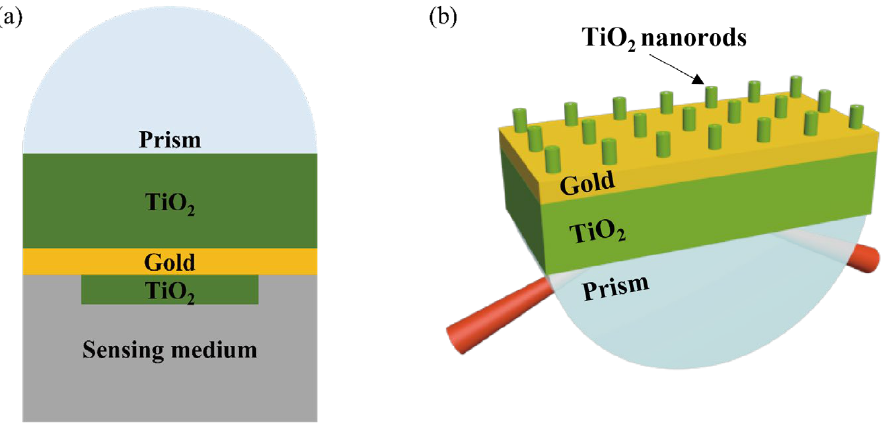
Figure 7. Schematic diagram of TiO 2 (film)-Au-TiO 2 (nanorods) triple structure SPR sensor ( a ) 2D ( b ) 3D. Table 2. Sensitivity, FWHM, and FOM data for different heights of TiO 2 nanorods of TiO 2 (film)-Au- TiO 2 (nanorods) triple structure SPR sensor.